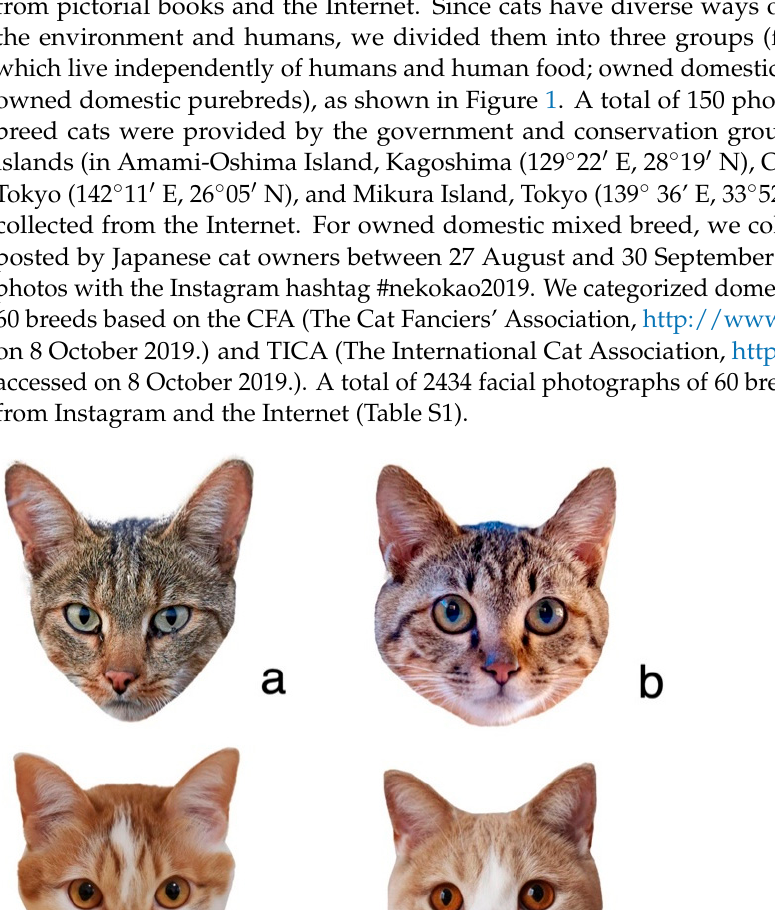
Figure 2. Measurement of facial morphology: A—distance between the right eye and left eye; B— length from the center line of the eye to the bottom of the nose; C—angle of the right eye; D—angle of the left eye. 2.2. Study 2 We investigated how the number of years the cat lived with the owner at the time of the survey (hereafter, “years with the owner”) is related to facial morphology in owned domestic mixed breed. We used the Feline Behavioral Assessment and Research Ques- tionnaire (Fe-BARQ) [35], a behavioral assessment (Table S2), and conducted a question- naire survey of the owners of the 661 cats included in Study 1. Using the data from the 428 cat owners who responded, we examined the association with the facial morphology data measured in Study 1. We ran a generalized linear model (GLM), using a glmer func- tion with Poisson distribution in the lme4 package version 1.1.10 with R version 3.6.0. Explanatory variables were items related to sex, years with the owner, and Fe-BARQ be- haviors toward humans (sociability with people, stranger-directed aggression (Table S2)), while response variables were nose length or eye angles.